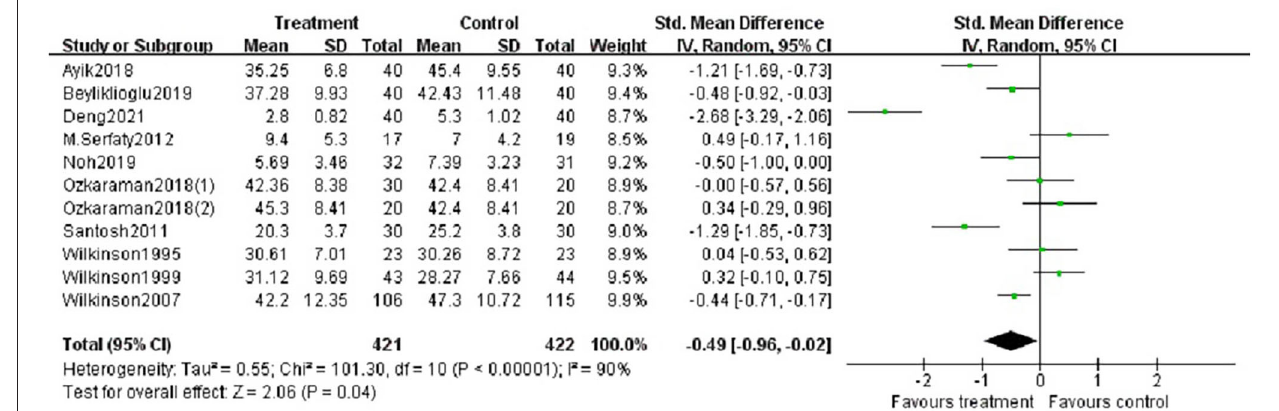
FIGURE 4 | Forest plot showing the pooled effects of aromatherapy on anxiety.